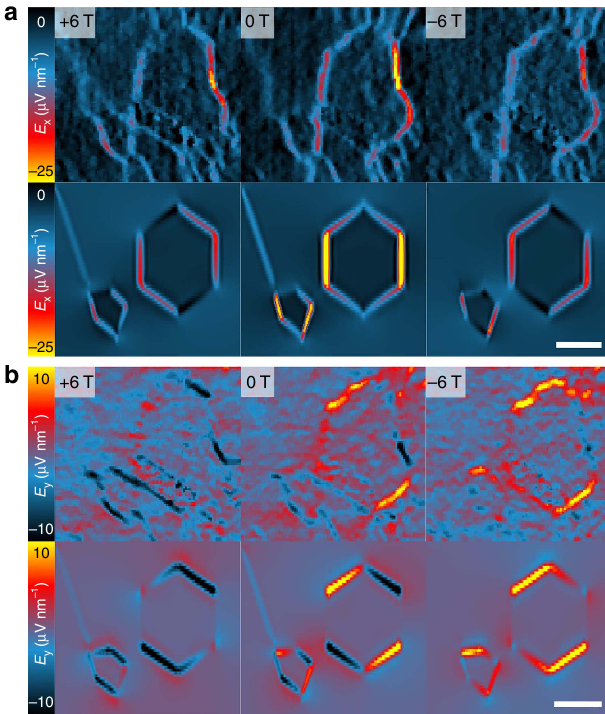
Figure 3 | Local change of electric fields. ( a ) Electric field component E x for the area surrounding the MLG island derived from the potential maps in Fig. 1e ( (cid:2) 6T/0T/ þ 6T, area: 350 (cid:5) 350nm 2 ). The lower row shows finite-element method simulations (see Supplementary Note 5) of the area with simple geometries for the ML/BL interfaces and the wrinkle on the left. ( b ) Analysis of the electric field component E y analogous to a